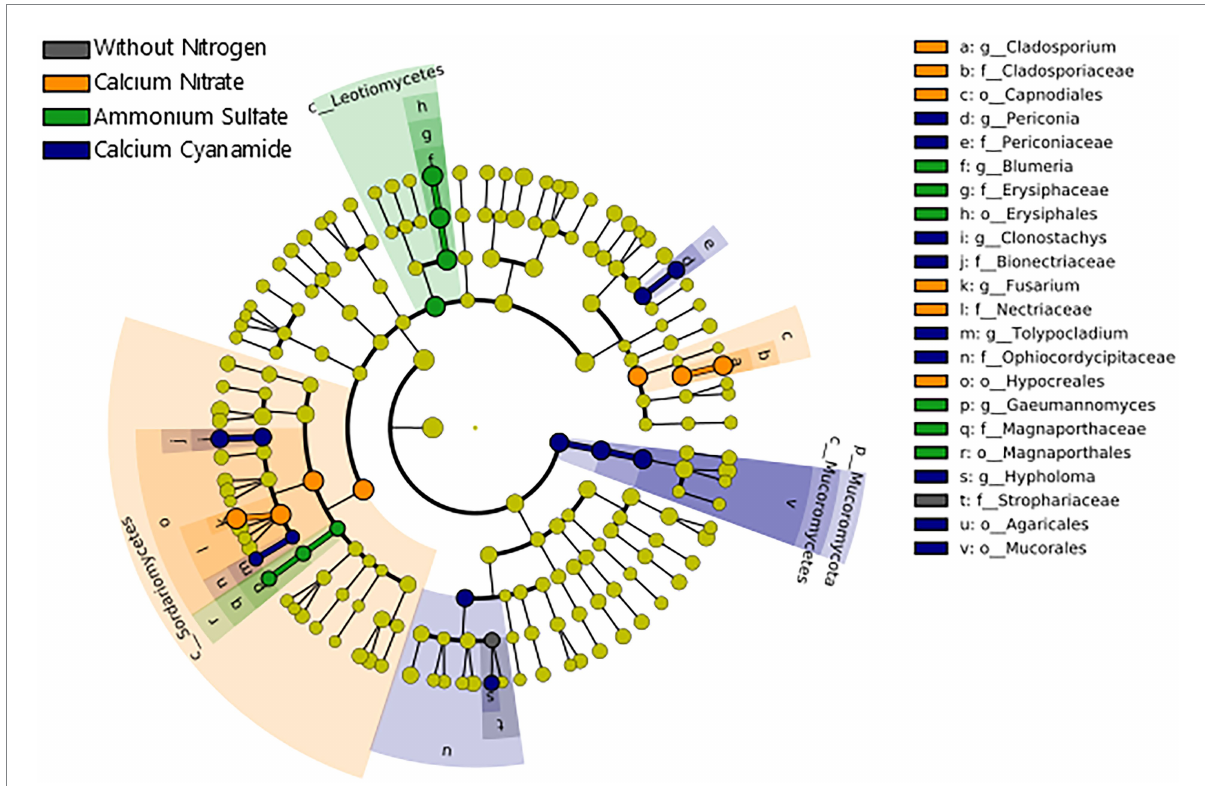
FIGURE 7 Cladogram illustrating the taxonomic groups explaining the most variation among the fungal taxa. Each ring represents a taxonomic level, with phylum (p_), class (c_), order (o_), family (f_), and genus (g_) emanating from the center to the periphery. Each circle is a taxonomic unit found in the dataset, with circles or nodes shown in colors (other than yellow) indicating where a taxon was significantly more abundant. Black: without nitrogen, orange: calcium nitrate, green: ammonium sulfate, blue: calcium